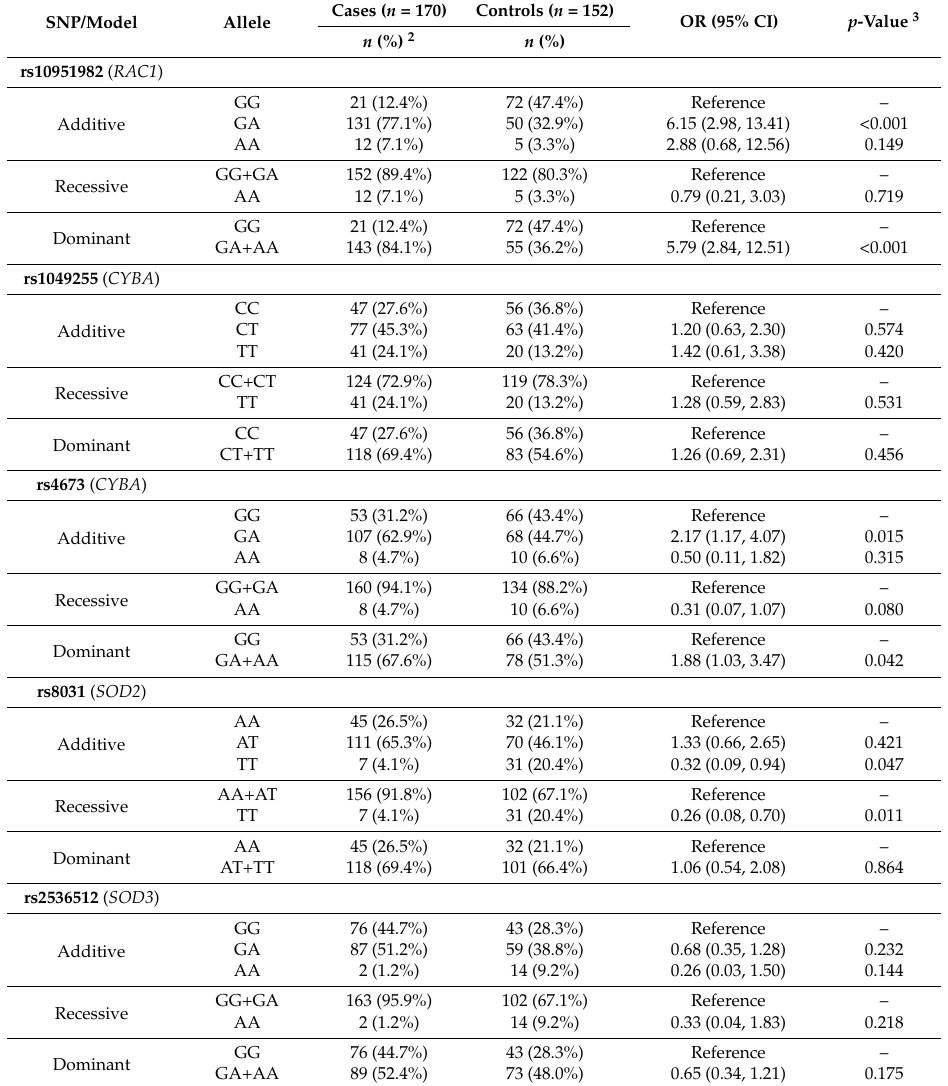
Table 5. Adjusted 1 associations between the top five SNPs and melanoma